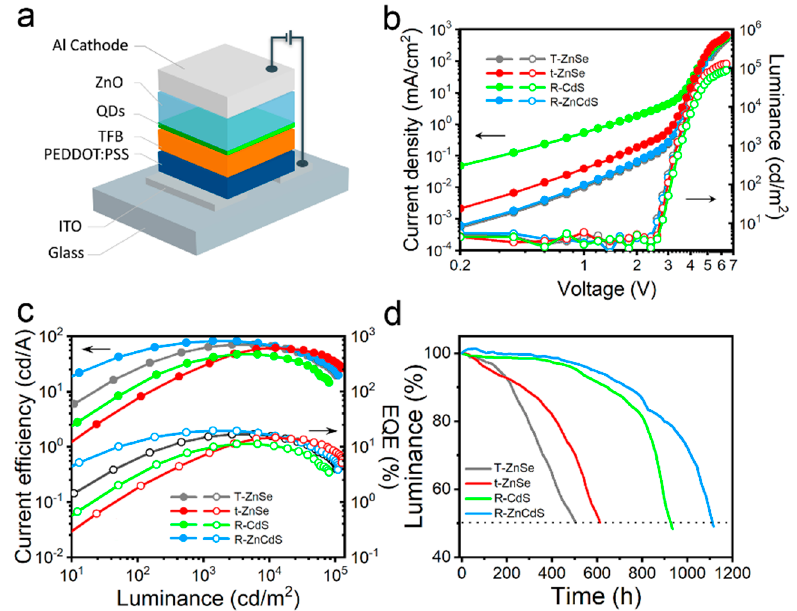
Figure 5. ( a ) Schematic illustration of QLEDs. ( b ) Current density and luminance versus voltage profiles. ( c ) Current efficiency and EQE as a function of luminance of the green QLEDs based on T − ZnSe, t − ZnSe, R − CdS and R − ZnCdS quantum dots. ( d ) Luminance versus time of operation under ambient conditions of T − ZnSe, t − ZnSe, R − CdS and R − ZnCdS devices. Table 2. Summary of maximum current efficiency (CE, cd/A), luminance (Lmax, cd/m 2 ), EQE (%) and lifetime (h) of